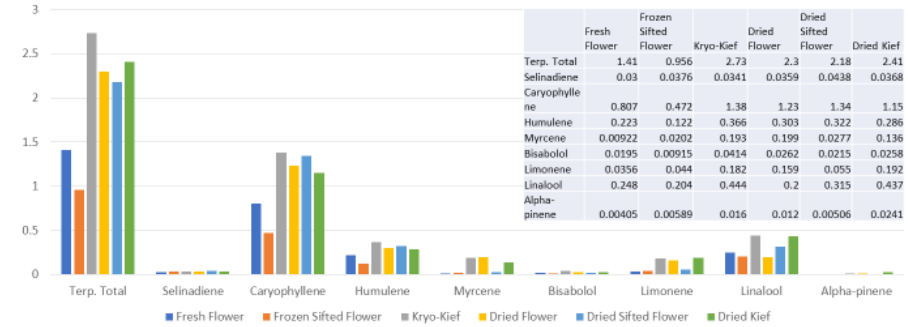
Figure 9. Ursa Major Type I chemovar terpenoid assay results (all figures are %). Figure 8. Ursa Major Type I chemovar terpenoid assay results (all figures are